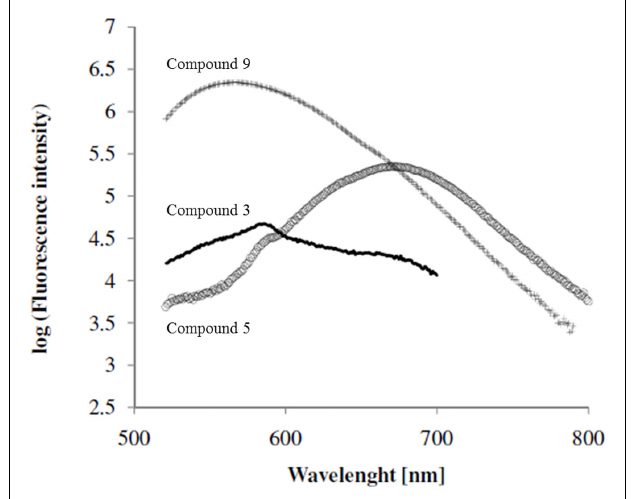
FIGURE 2 | Fluorescence emission spectra of selected chalcone derivatives.